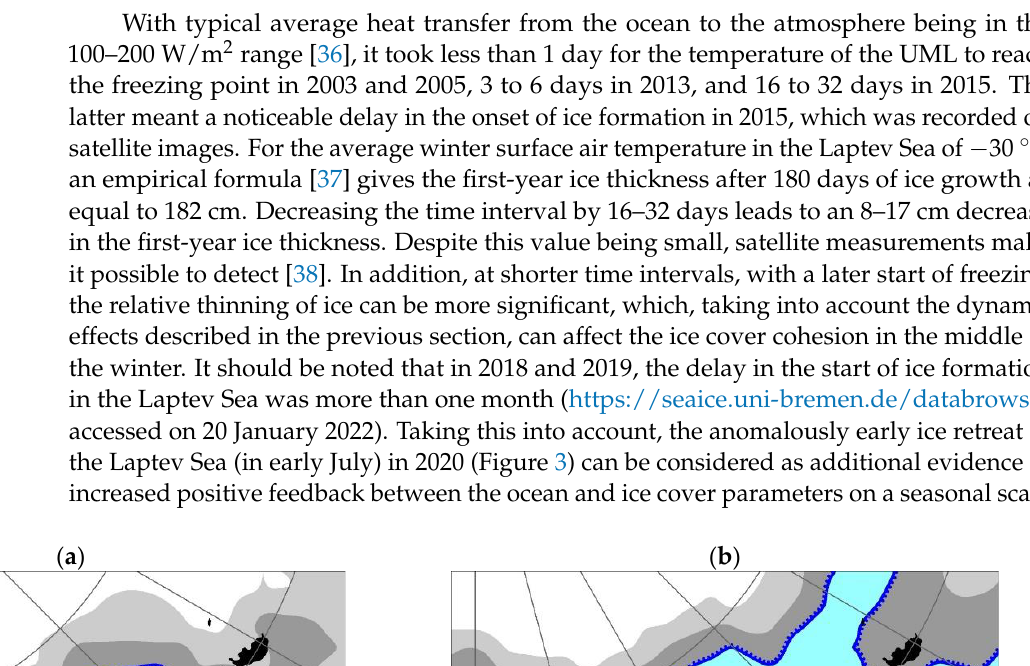
Figure 2. ( a ) Time series of the duration of the period of open water (ice concentration less than 15%) in the Laptev Sea ( a ), based on data from [5]; ( b ) SST anomaly in August – September on the Laptev Sea shelf, based on ERA5 atmospheric reanalysis data.